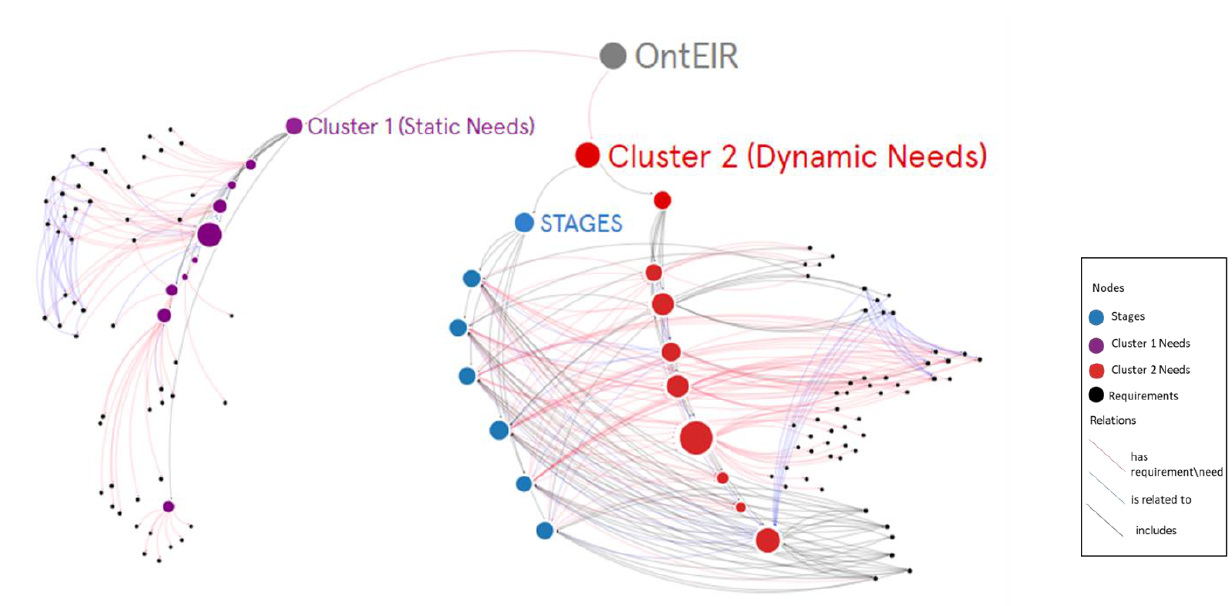
Figure 3. Visualisation of the BIM Information Delivery Lifecycle Needs (Static and Dynamic Needs).